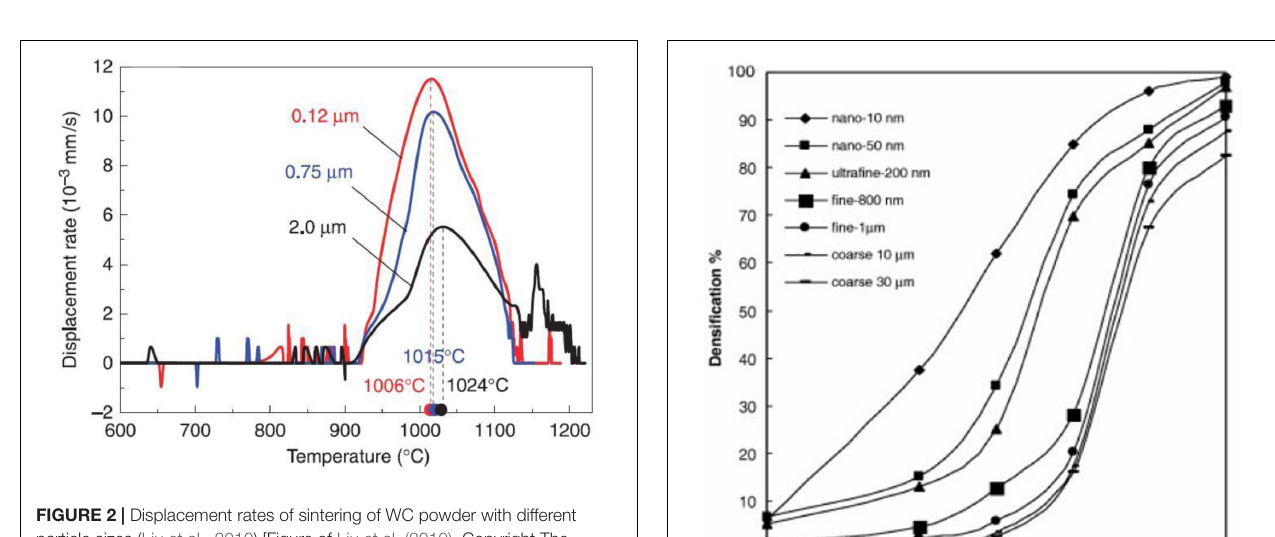
FIGURE 2 | Displacement rates of sintering of WC powder with different particle sizes (Liu et al., 2010) [Figure of Liu et al. (2010), Copyright The American Ceramic Society].